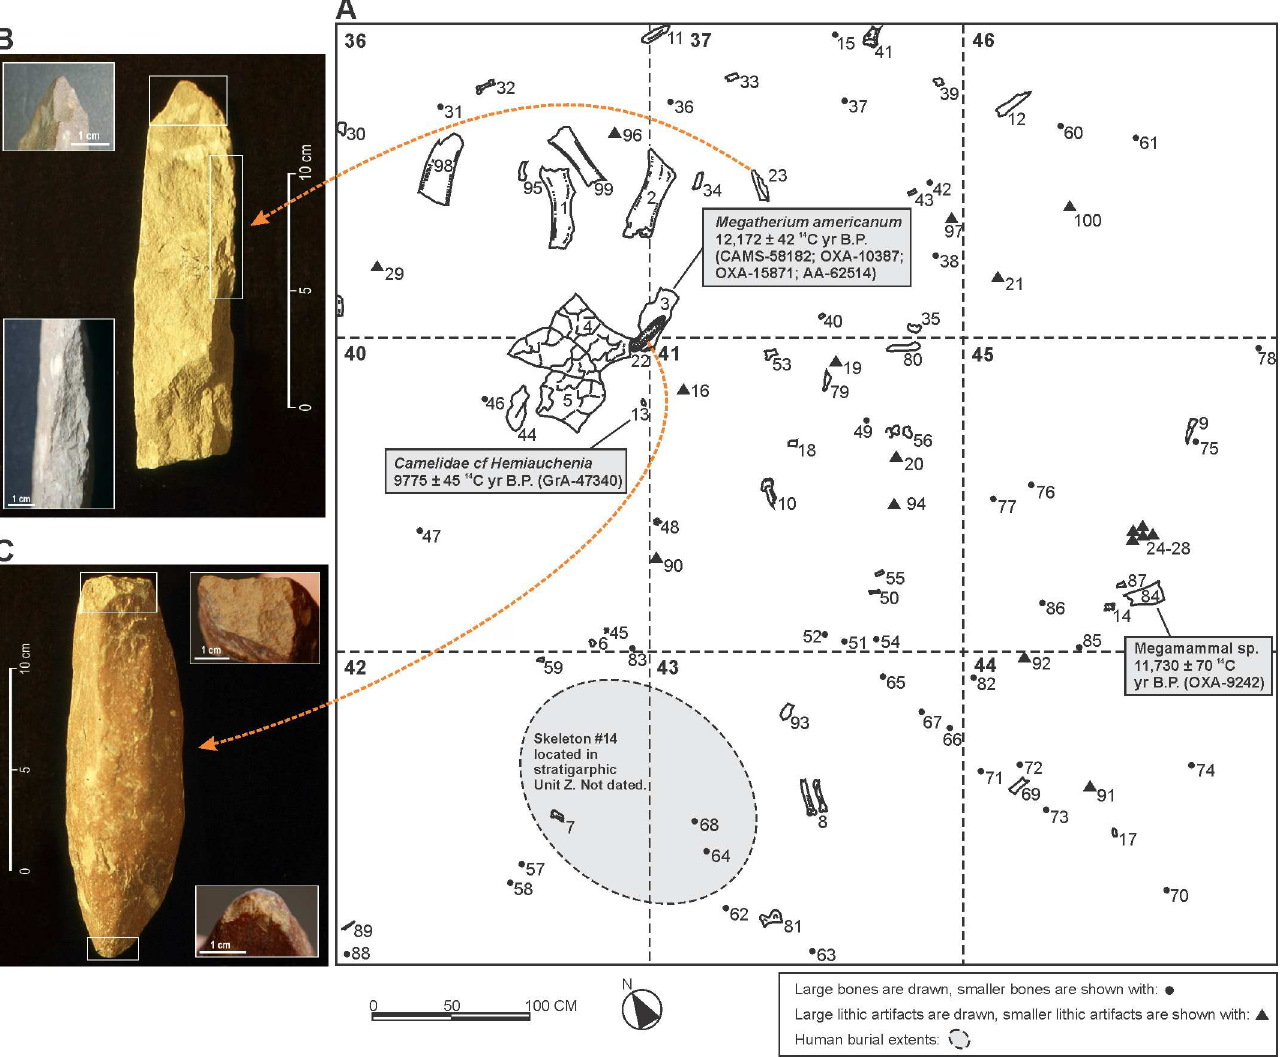
Fig 5. Exampleof the spatialassociation betweenbone,lithicartifacts, and humanburials at the AS2 site. (A) Horizontaldistribution map of centralexcavation units 36, 37, 40 to 46 (see S1 Table for map references).(B) Lutitaartifactwith detail of flaked edges. (C) Oval shaped cobble (rhyolite) with detailof fractureand roundededge. Note:All materialwas recovered fromthe lower partof stratigraphic Unit Y with the exception of Skeleton # 14 (a singleindividualadult primaryskeleton locatedin the lower stratigraphic Unit Z). doi:10.1371/journal.pone.0162870.g005 PLOS ONE | DOI:10.1371/journal.pone.0162870 September28,